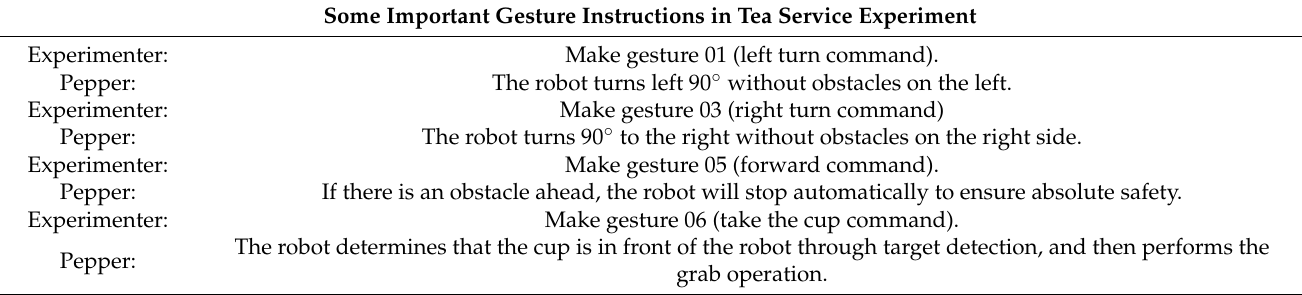
Table 4. Instructions of experimental operation.